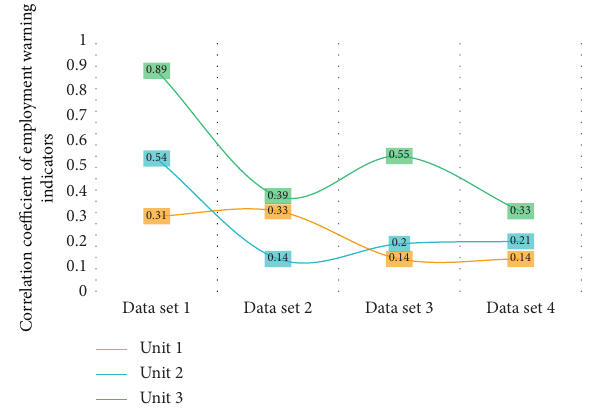
Figure 7: Correlation coefficient curve of employment early warning indicators.